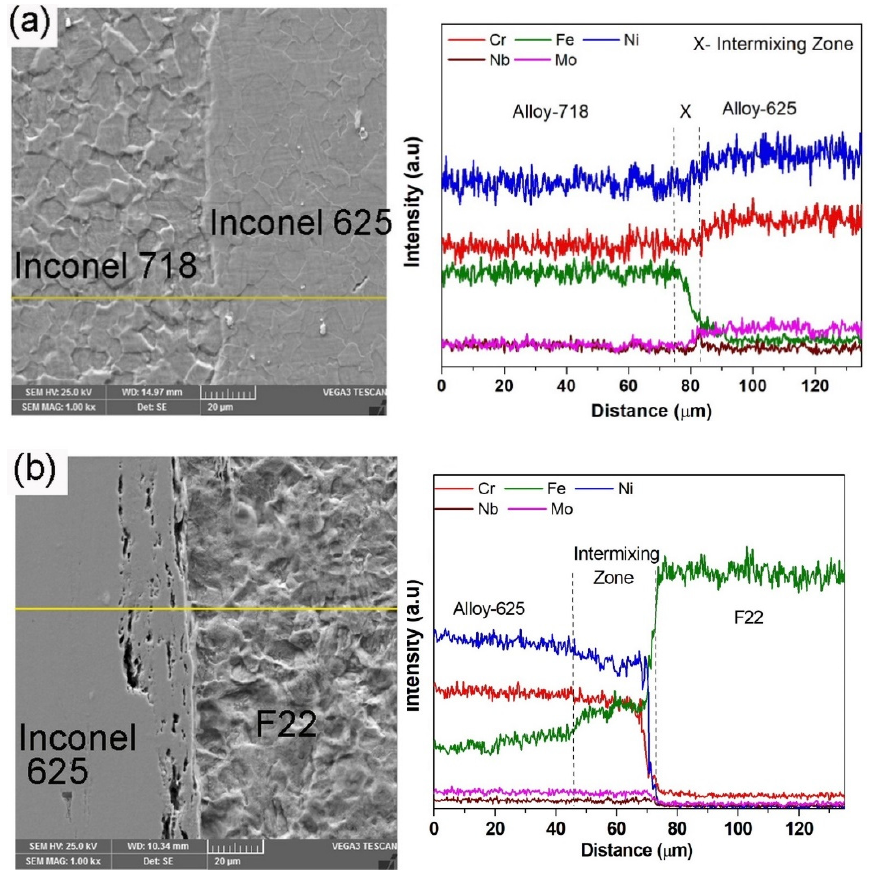
Figure 6. SEM micrograph of weldment at ( a ) 718/625 interface (5 mm burn-off) with EDS line scan and ( b ) 625/F22 (7 mm burn-off) interface with EDS line scan.